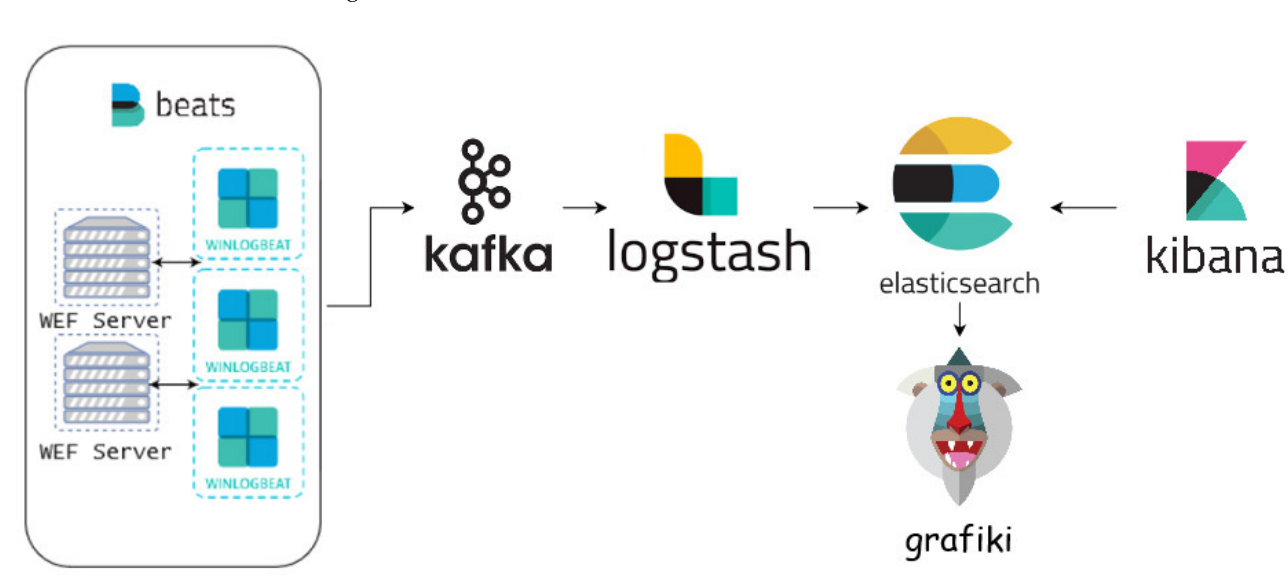
Figure 2. Event Based Detection System (EBDS) Diagram.